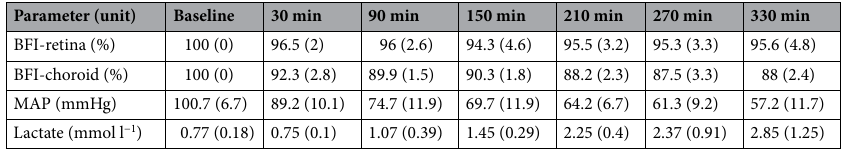
Table 1. Changes of BFI, MAP, and lactate in 6-h severe rat sepsis model.